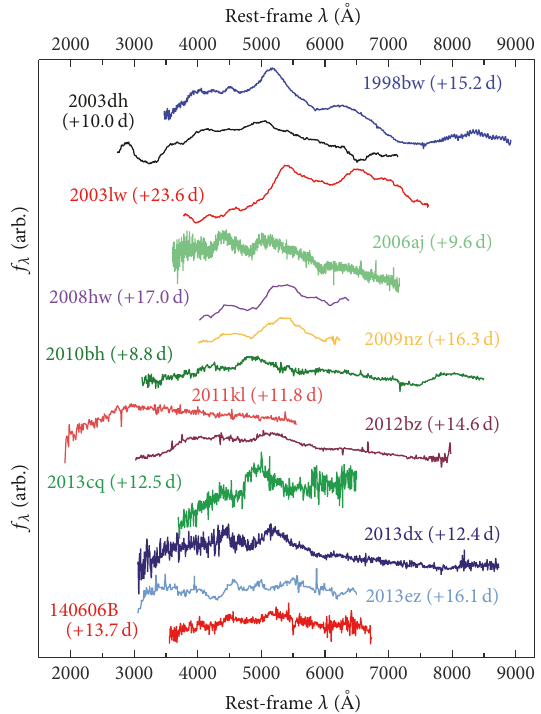
Figure 5: Peak/near-peak spectra of GRB-SNe. The spectra have been arbitrarily shifted in flux for comparison purposes and to exaggerate their main features, and host emission lines have been manually removed. The spectra of SNe 2012bz, 2013cq, and 2013dx have been Kaiser smoothed [31] in order to suppress noise. Most of the spectra are characterized by broad absorption features, while such features are conspicuously absent in the spectra of SN 2013ez and SN